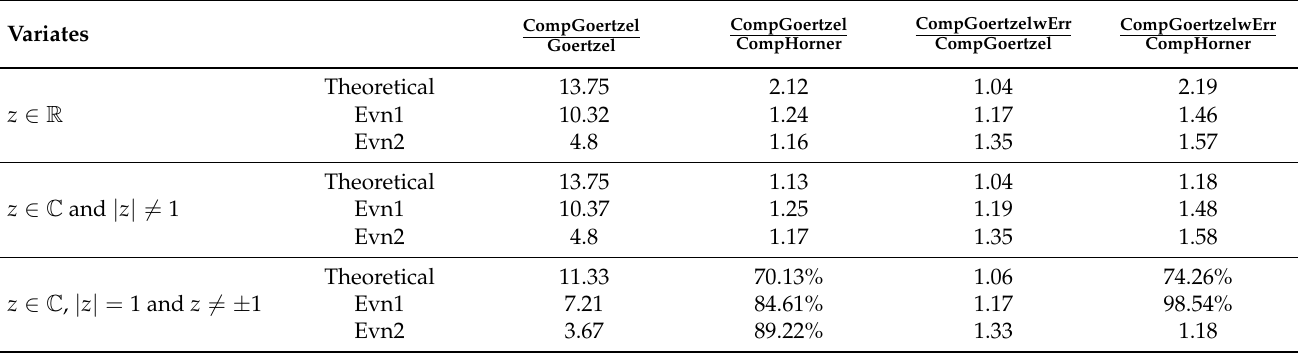
Table 4. Theoretical computational complexity and measured running time ratios in a n ∈ C